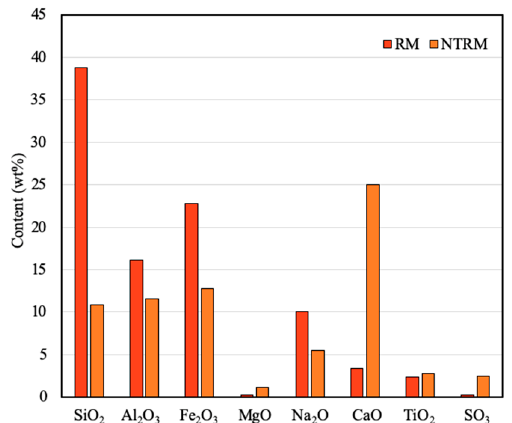
Figure 2. Oxide chemical compositions of RM and NTRM.